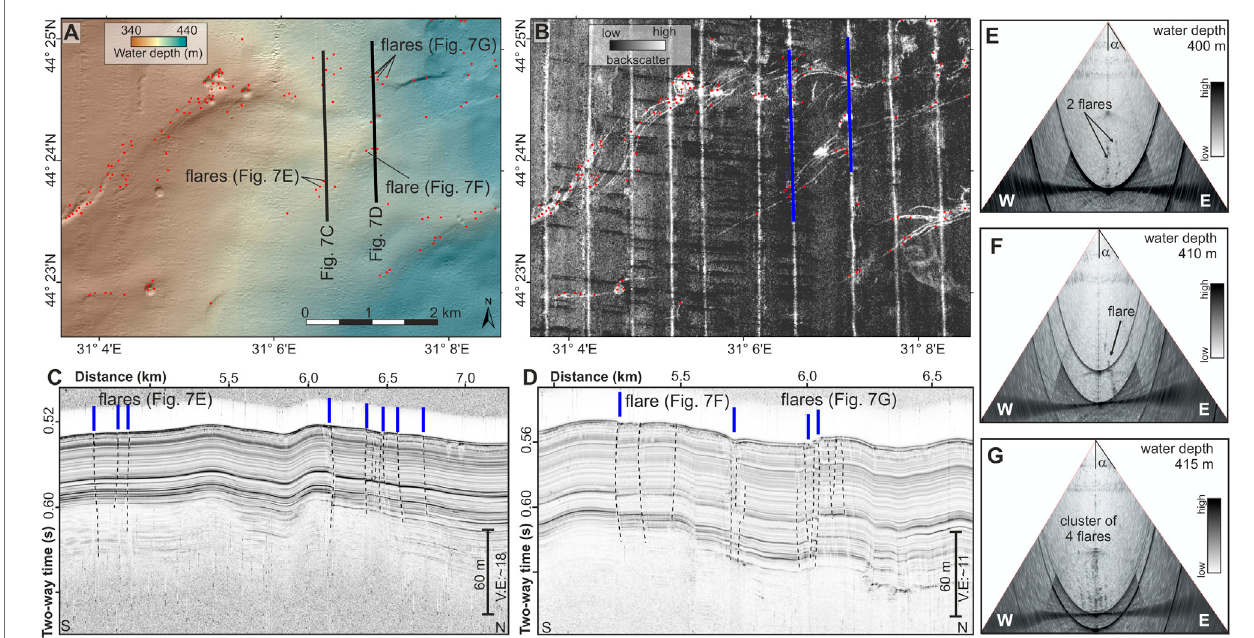
FIGURE7| NormalfaultsintheregionoftheN2-channelsystemshowbranchingintoseveralsmallersub-faultsasseenin (A) themultibeambathymetryand (B) as highsea fl oorbackscatterreturn. (C) Subbottompro fi lerdata(black/bluelinein (A,B)